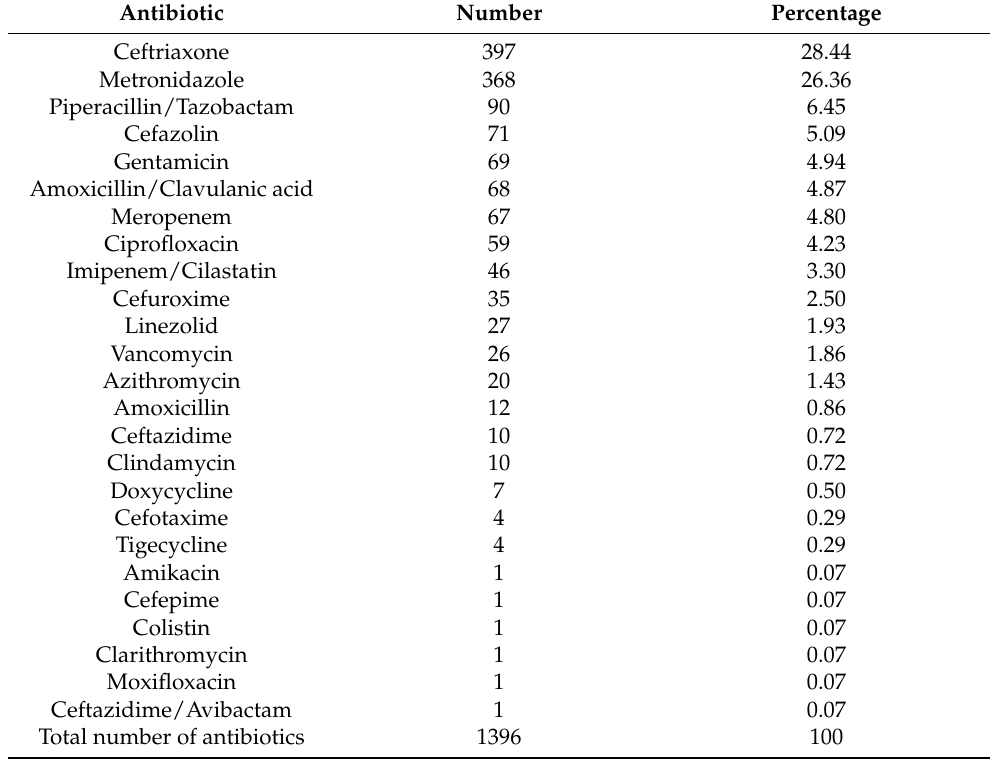
Table 1. Number of different antibiotics prescribed in the surgical